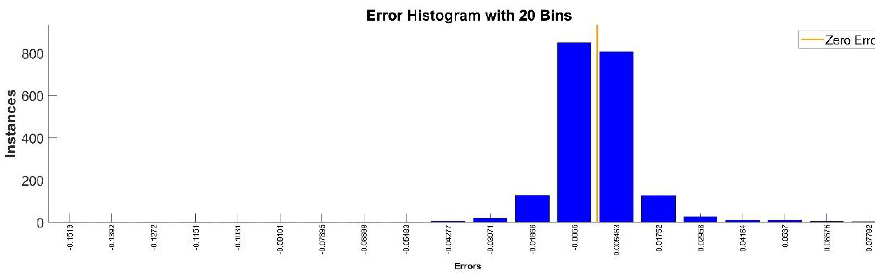
Figure 22. Error histogram between the target values and the estimated values for q 4 .